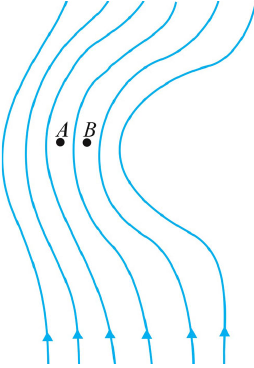
FIG. 11. Streamlines of a fluid moving in a vertical direction which encounters an obstacle (not represented